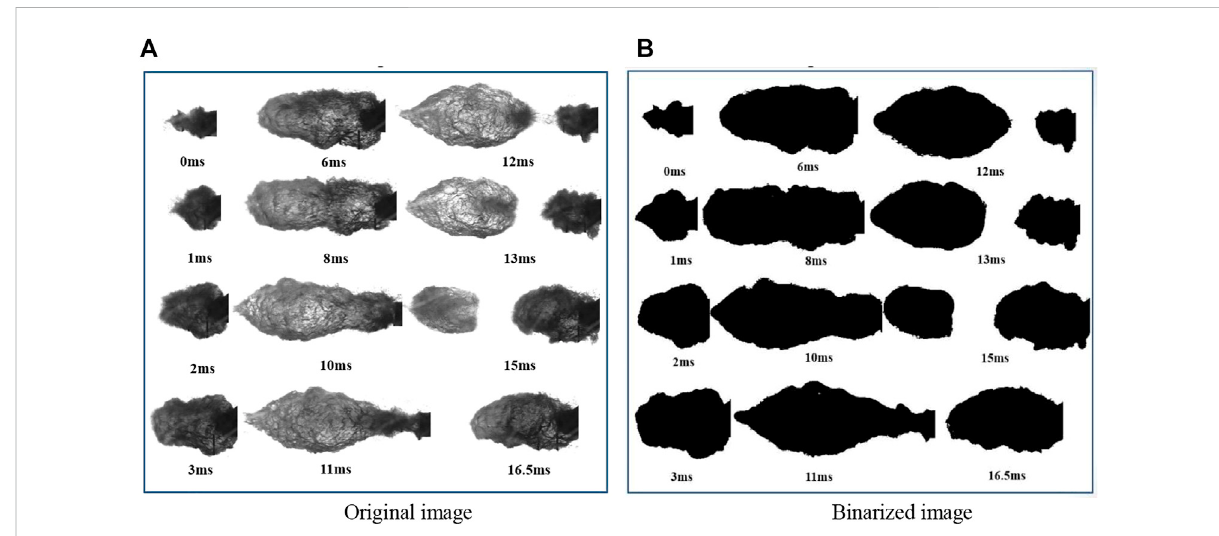
Comparison of the original image and binarized image. (A) Original image. (B) Binarized image.